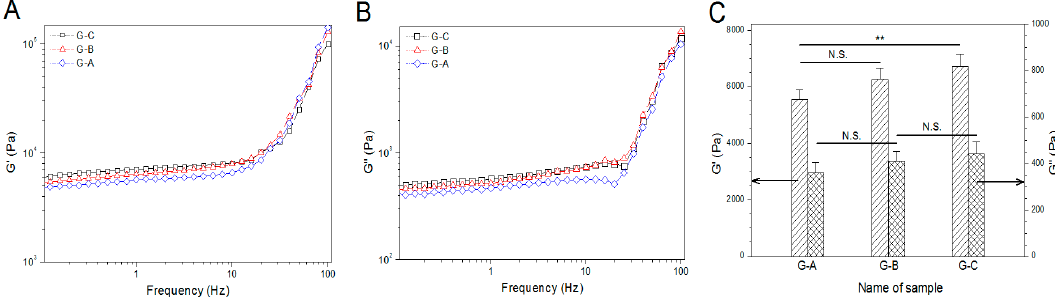
Figure 5. Frequency dependent functions ( A , B ) of modulus and average values ( C ) of modulus at 1.0 Hz and 37 ° C for BG/ALG–POL/SF gels ( ∗∗ , p < 0.001; N.S., no significance).